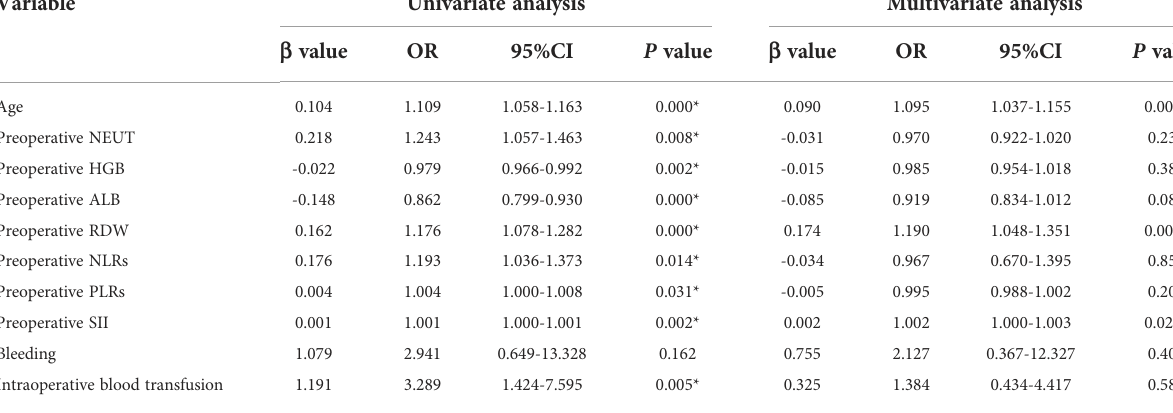
TABLE 6 Logistics analysis of risk factors related to postoperative pulmonary complications.